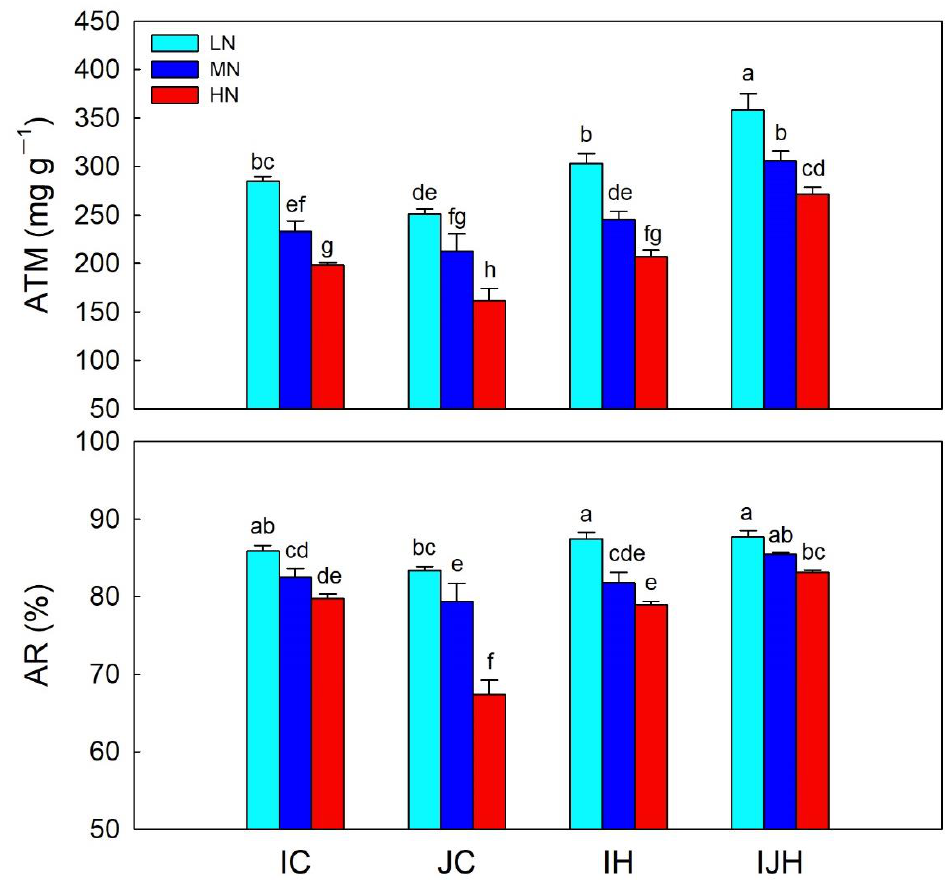
Figure 2. The stem ATM and AR of different rice varieties under different nitrogen application lev- els. Different letters on top of histograms indicate significant differences at p < 0.05 among different rice varieties under different nitrogen application levels. IC, indica conventional rice; JC, japonica conventional rice; IH, indica hybrid rice; IJH, indica-japonica hybrid rice; LN, low nitrogen; MN, medium nitrogen; HN, high nitrogen; ATM, apparent transferred mass; AR, apparent transferred ratio.